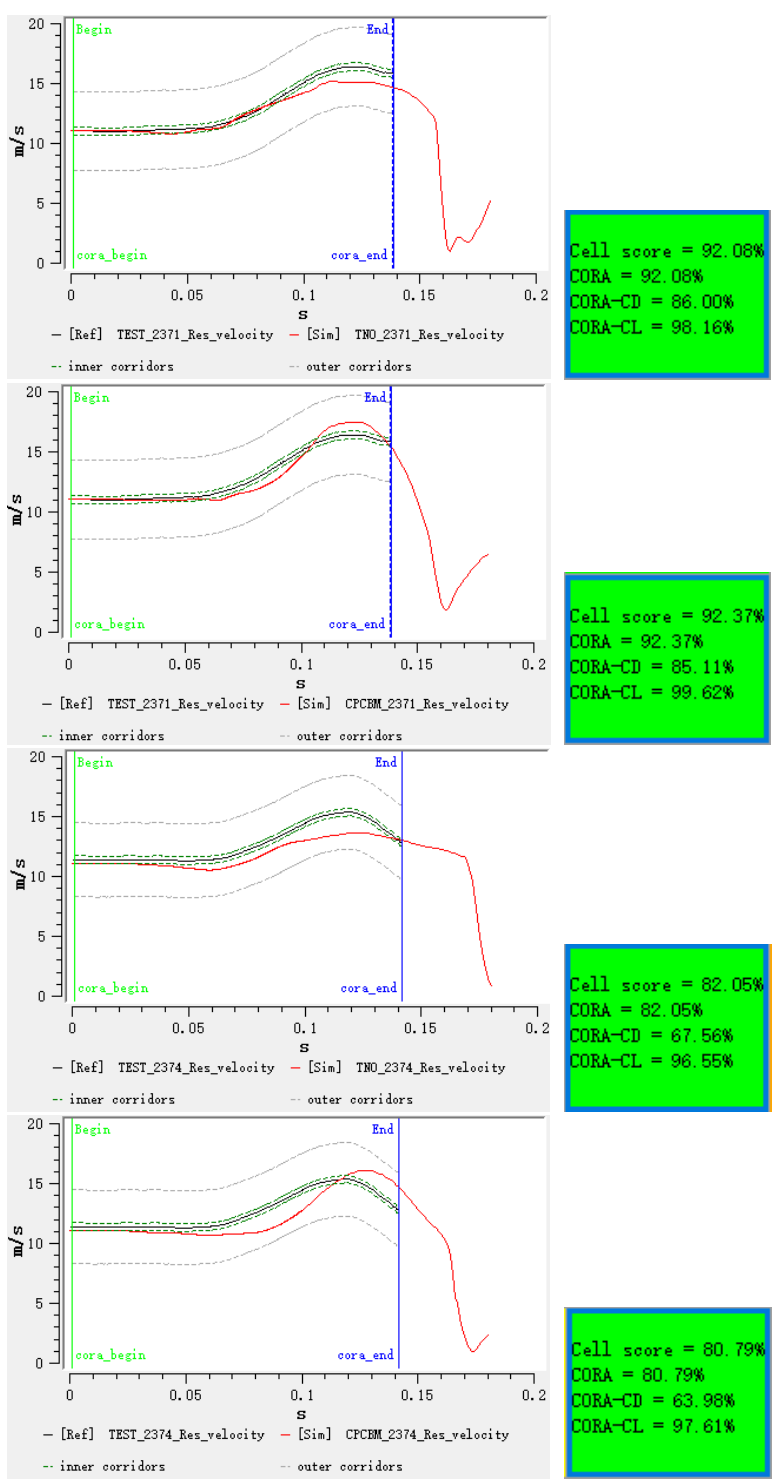
Figure A14. Resultant velocity signals relative to the sedan buck between experiment and simulation.